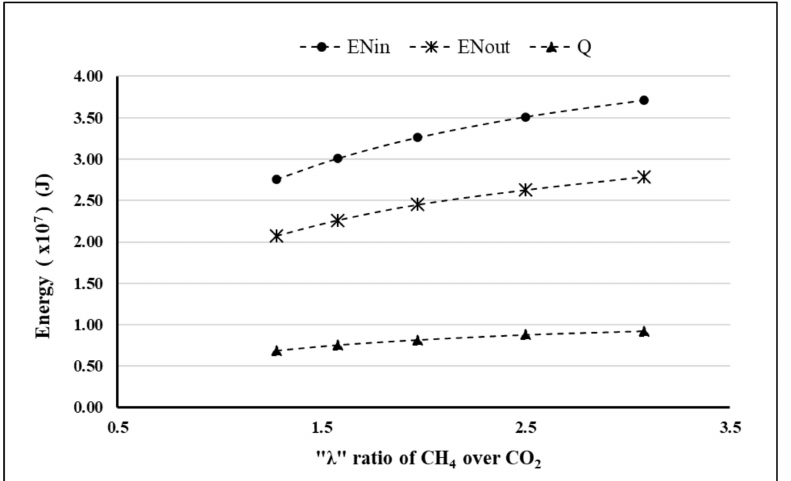
Figure 5. Effect of “ λ ” on system’s inlet energy (ENin), the produced electricity (ENout) and the thermal wastes to the environment